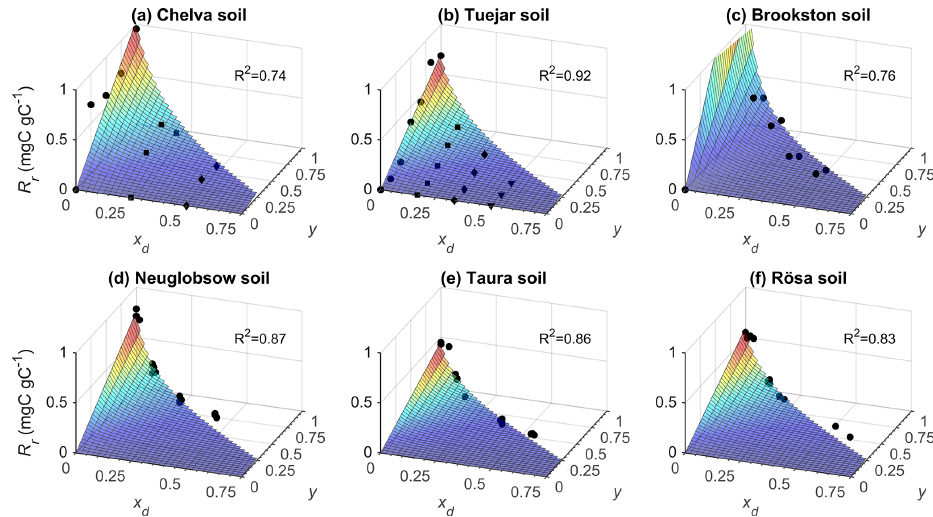
Figure 2. Relations between respiration pulse size ( R r , normalized by soil organic C content) and pre-wetting soil moisture ( x d ) and soil moisture increment at rewetting ( y ), for six soils; top row: mineral soils; bottom row: organic soils. Symbols represent measured respiration pulses, and surfaces are fitted R r functions from Eq. (13) (soil characteristics, fitting parameters, and data sources are reported in Table 2).